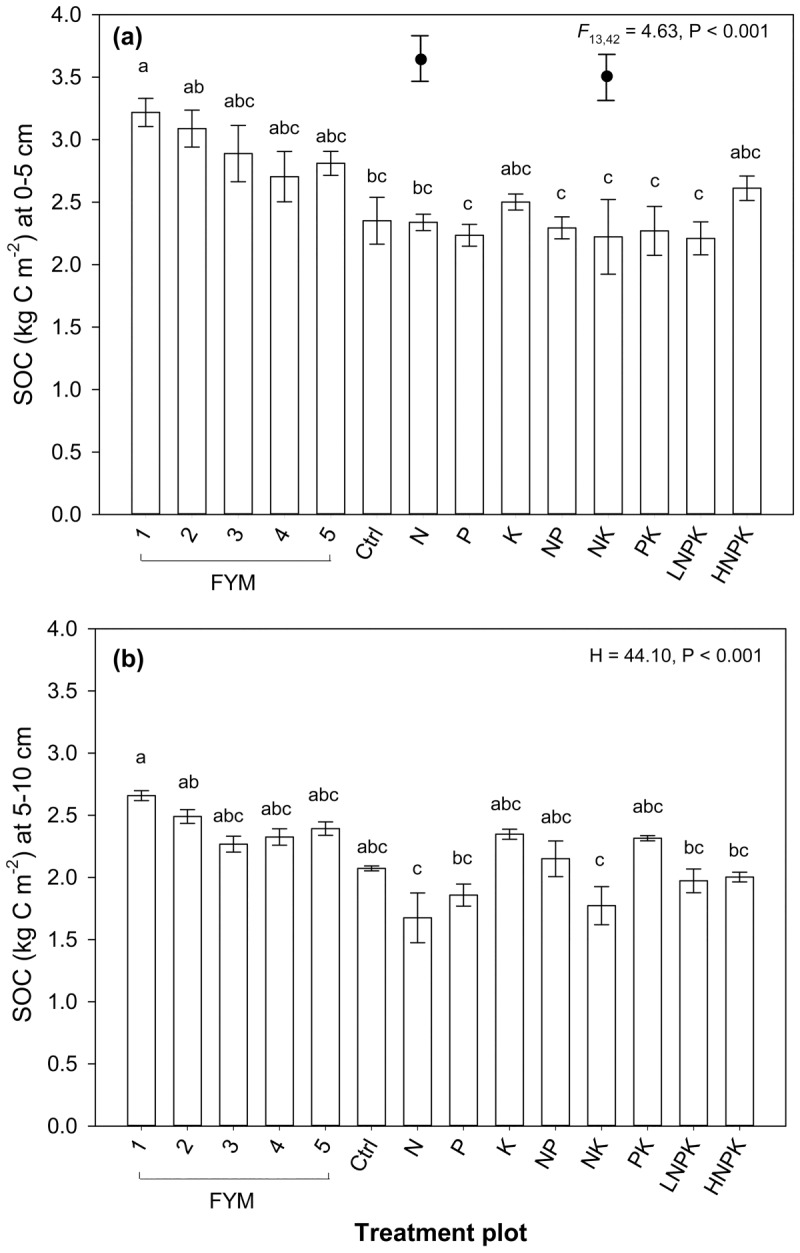
Effect of fertilizer treatment plot on (a) soil organic carbon stocks at 0–5 cm and (b) soil organic carbon stocks at 5–10 cm. Error bars represent ±1 standard error of the treatment plot mean and contrasting letters denote significant differences between treatment plots. H is the Kruskal-Wallis test statistic. Filled ellipses with error bars represent the mean and ±1 standard error for the O horizon in plots 7 (N) and 11 (NK).